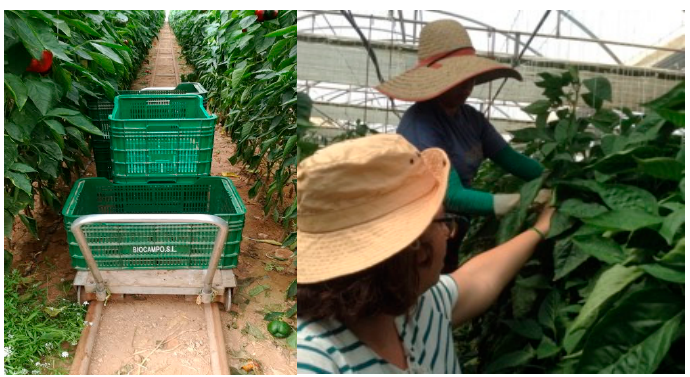
Figure 2. Complementary use of heating system and specialization of farmers.